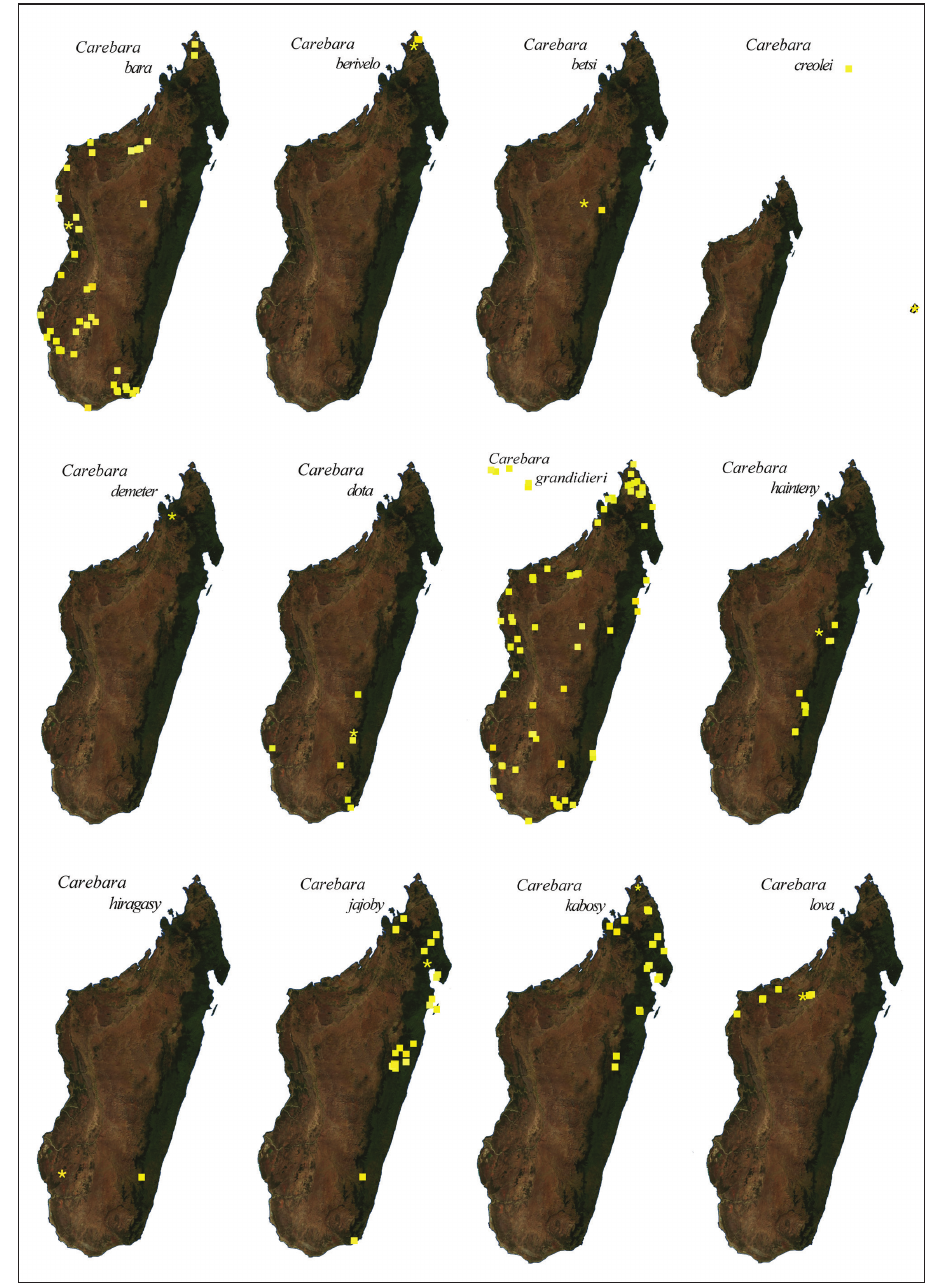
Figure 68. Distribution maps of Malagasy Carebara species: C . bara. C. berivelo , C. betsi , C. creolei , C. demeter , C. dota , C. grandidieri , C. hainteny , C. hiragasy , C. jajoby , C. kabosy C lova ; type localities are indicated by